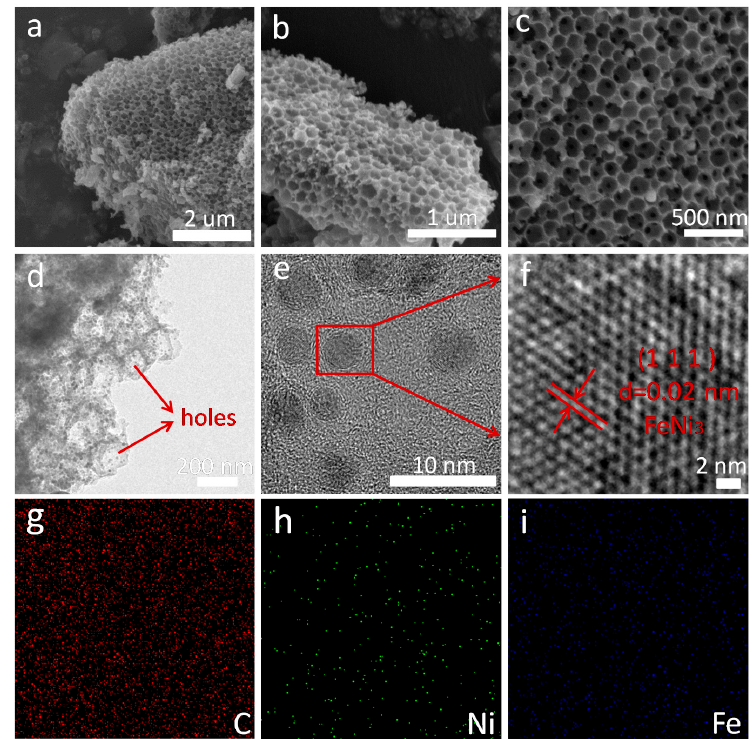
Figure 3. SEM images of S2 at ( a ) low, ( b ) medium, and ( c ) high magnification. ( d – f ) TEM images of S2 at different resolutions. EDS mapping images of ( g ) C, ( h ) Ni, and ( i ) Fe elements.